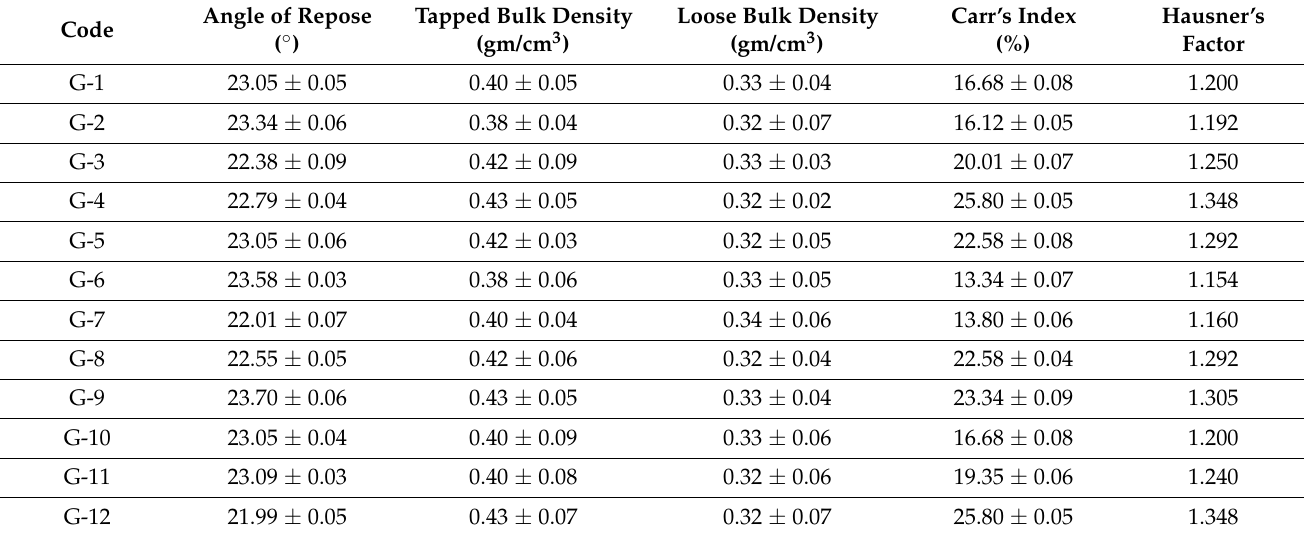
Table 1. Physical properties of granules obtained from different formulations ( n =